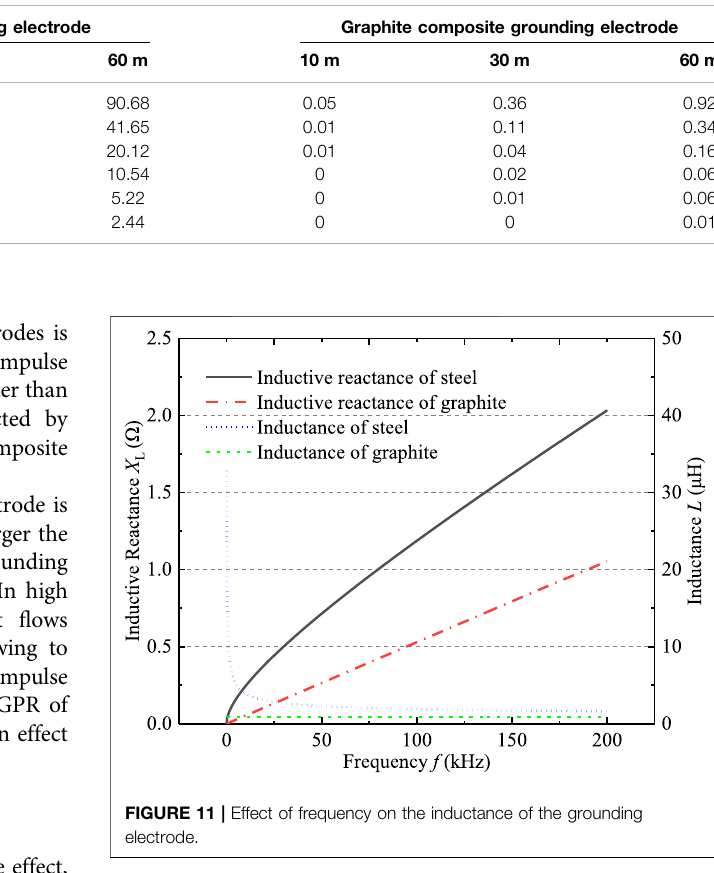
TABLE 3 | In fl uence rate η s of skin effect (%).